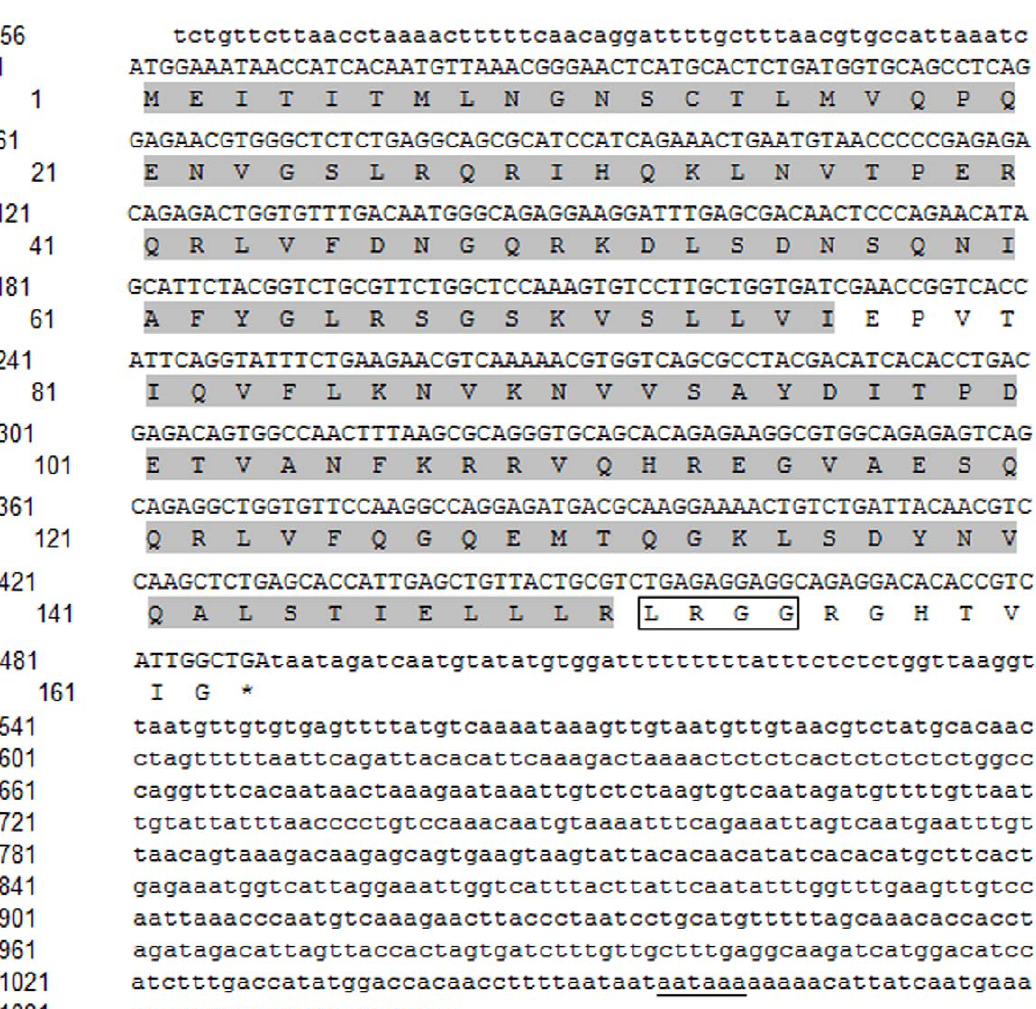
Figure 1. The nucleotide and deduced amino acid sequences of CsISG15. The nucleotides and amino acids are numbered along the left margin. In the nucleotide sequence, the translation start and stop codons are in bold, and the polyadenylation signal is underlined. In the amino acid sequence, the two ubiquitin-like (UBL) domains are shaded, and the ubiquitin conjugation motif (LRGG) is boxed.